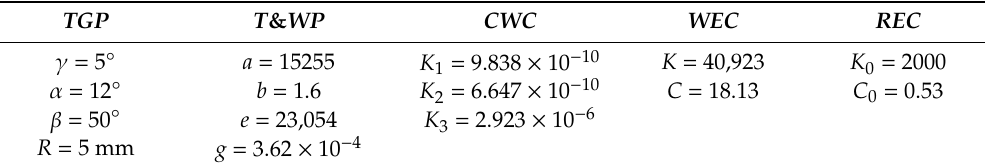
Table 4. Simulation input parameters.